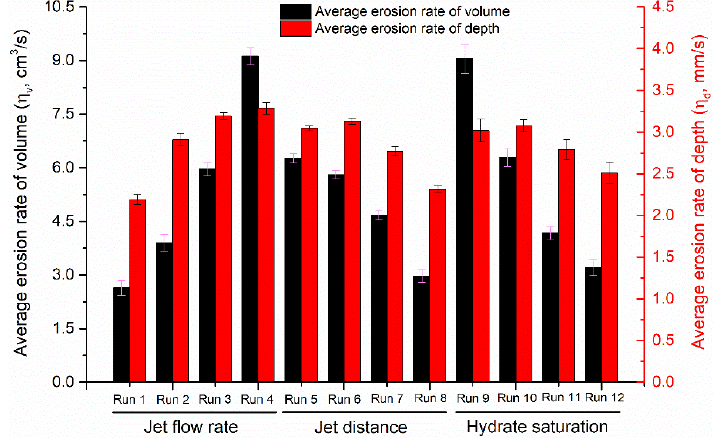
Figure 11. The influence of jet parameters and hydrate saturation on the average erosion rate of volume and average erosion rate of depth.